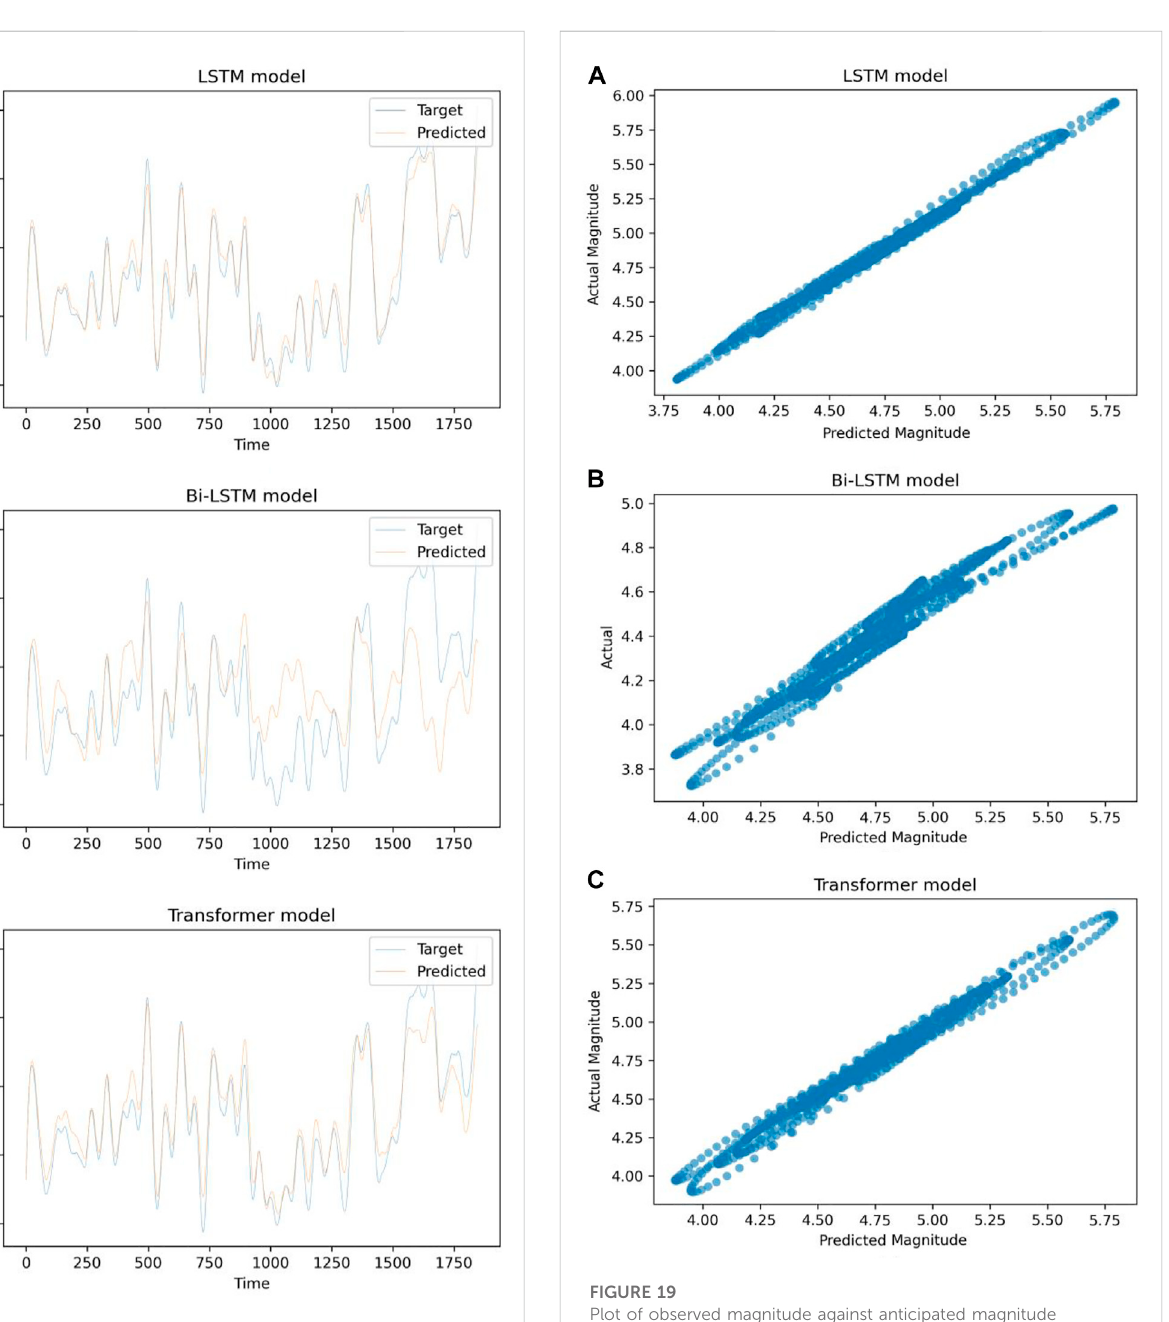
Table 3. The transformer model outperformed the other models with the fewest deviation metrics when fed with an unknown test dataset. In the testing phase, the transformer model surpasses the